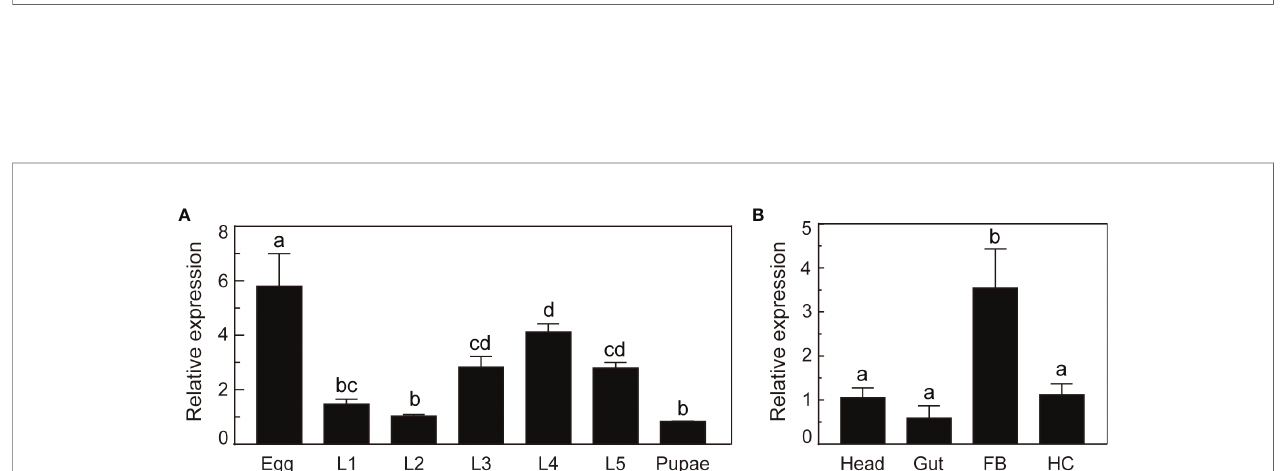
FIGURE 1 | Relationship between AcMNPV infection and the innate immune response in O. furnacalis . (A) Analysis of viral replication after AcMNPV infection. Viral gDNA was extracted from larvae at 1/6/12/18 h after infection, and the relative viral amounts were determined by qRT – PCR. O. furnacalis ribosomal protein L8 ( rpL8 ) was used as the internal control. The bars represented the mean ± S.D. ( n = 3). Different marked letters indicated means that were signi fi cantly different (one – way ANOVA followed by Tukey ’ s multiple comparisons test, P < 0.05). (B) Analysis of PO activity after AcMNPV infection. Hemolymph (1 m L) collected from virus-infected or control larvae was incubated for 10 min at room temperature. PO activity was monitored using dopamine as substrate. The bars represented the mean ± S.D. ( n = 3). Statistical signi fi cance was determined using Sidak ’ s multiple comparisons test (* P < 0.05, ** P < 0.01). (C) Analysis of expression of serpin – 4 after AcMNPV infection. Fifth – instar larvae were injected with AcMNPV. The transcript level of serpin – 4 was assayed by qRT – PCR three hours later, and rpL8 was used as an internal standard. The bars represented the mean ± S.D. ( n = 3). Asterisks indicated means that were signi fi cantly different (unpaired t test, two – tailed, ** P < 0.01).